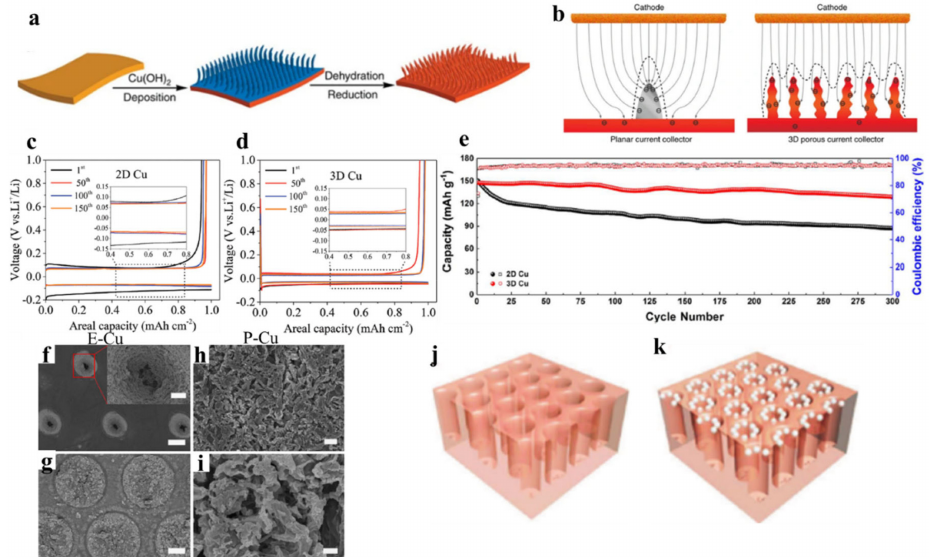
Figure 2. The lithium deposition behavior of Cu based porous framework. ( a , b ) Schematic illustration to prepare 3D porous Cu foil from planar Cu foil and the Li-ion flux distribution on planar and 3D